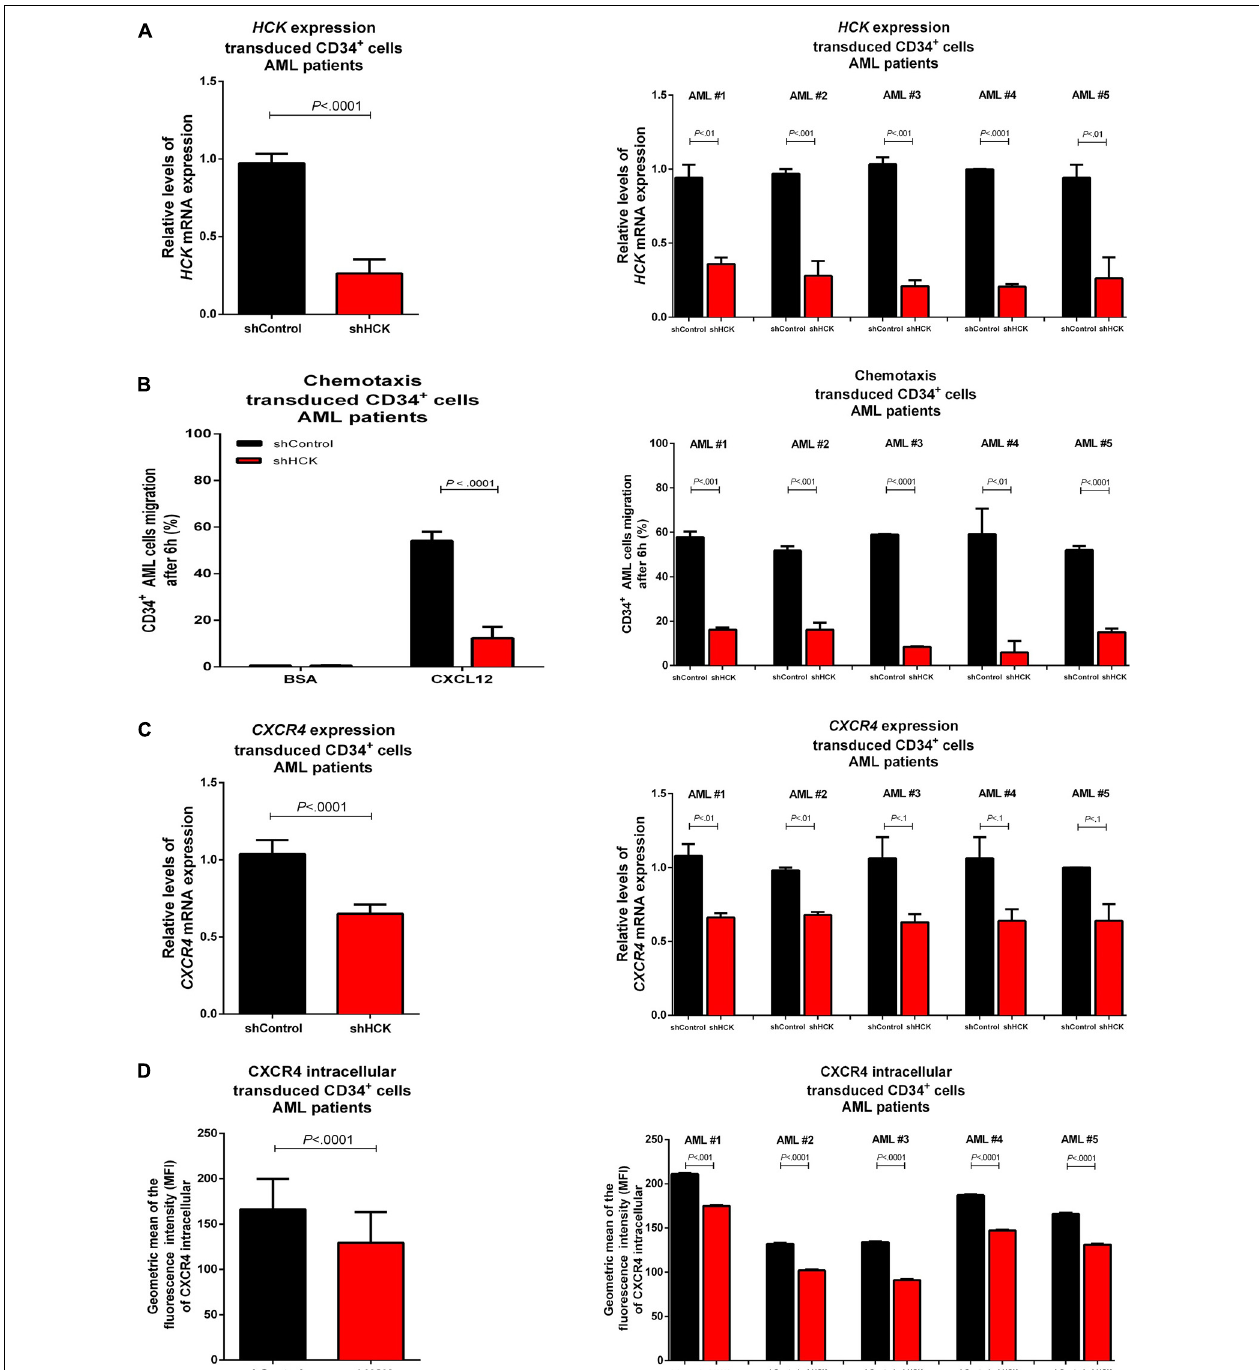
FIGURE 2 | HCK acts on CXCL12 chemotaxis in leukemia stem cells isolated from AML patients bone marrow. (A) HCK mRNA expression by qRT-PCR in transduced CD34 positive cells. Results were calculated for each sample relative to the expression of the endogenous reference HPRT gene and determined using the 2 − (cid:49)(cid:49) CT method. All data have been normalized to the values of the control. (B) Chemotaxis assays in transduced CD34 positive cell. The Transwell system was used to detect the chemotaxis of shControl or shHCK cells toward CXCL12 (100 ng/mL), using 10% FBS-containing medium as a positive control, and 0.5% BSA -containing medium as the negative control. After 6 h, the migrated cells on the lower chamber membrane were counted. (C) CXCR4 mRNA expression in transduced CD34 positive cell. Results were calculated for each sample relative to the expression of the endogenous reference HPRT gene and determined by the 2 − (cid:49)(cid:49) CT method. (D) CXCR4 intracellular levels in transduced CD34 positive cells. For flow cytometry, results were calculated using the MFI of CXCR4 intracellular expression after cell permeabilization. All data are represented as the mean of all 5 patients tested (graphic in the left) and the mean of the individual patient (graphic in the right). Results are shown as mean ± standard deviation and are representative of, at least, 4 independent experiments; Mann–Whitney test.